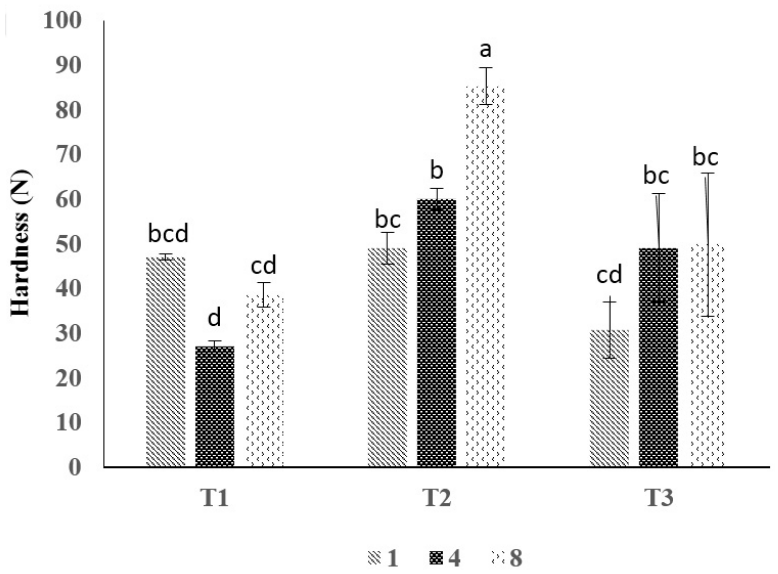
Figure 2. The effect of surimi-based coating on hardness of shrimp during storage at 4 ± 1 ◦ C. Data are given as mean values ± standard deviation ( n = 3). Different letters on the top of data bars indicate significant differences (Tukey’s test, p < 0.05) between mean values. T1, control; T2 surimi-based coating without MMT; T3, surimi-based coating with